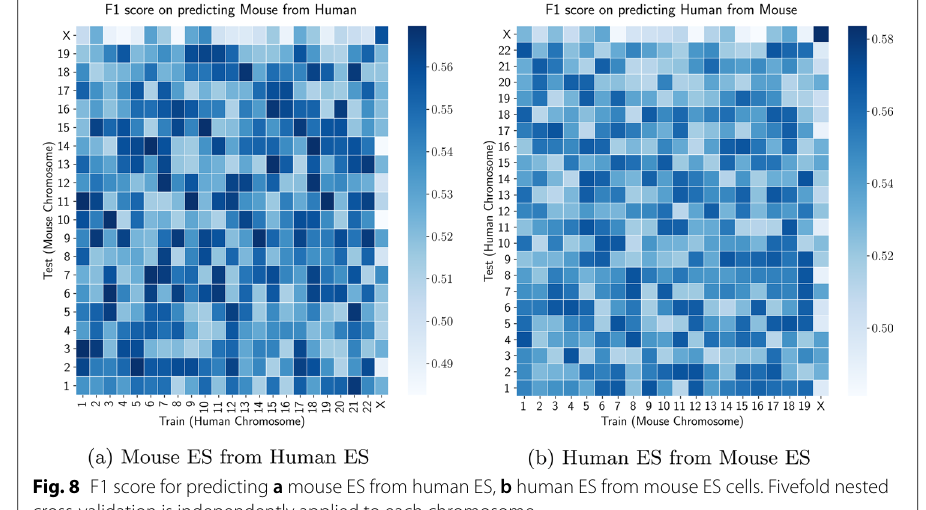
Fig. 8 F1 score for predicting a mouse ES from human ES, b human ES from mouse ES cells. Fivefold nested cross-validation is independently applied to each chromosome